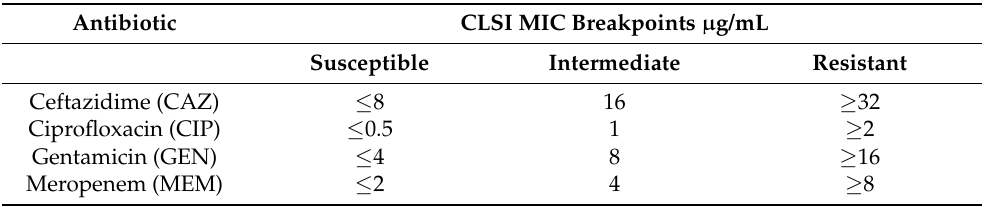
Table 2. CLSI MIC breakpoints for classifying antibiotic resistance in P. aeruginosa strains. Antibiotic CLSI MIC Breakpoints µ g/mL